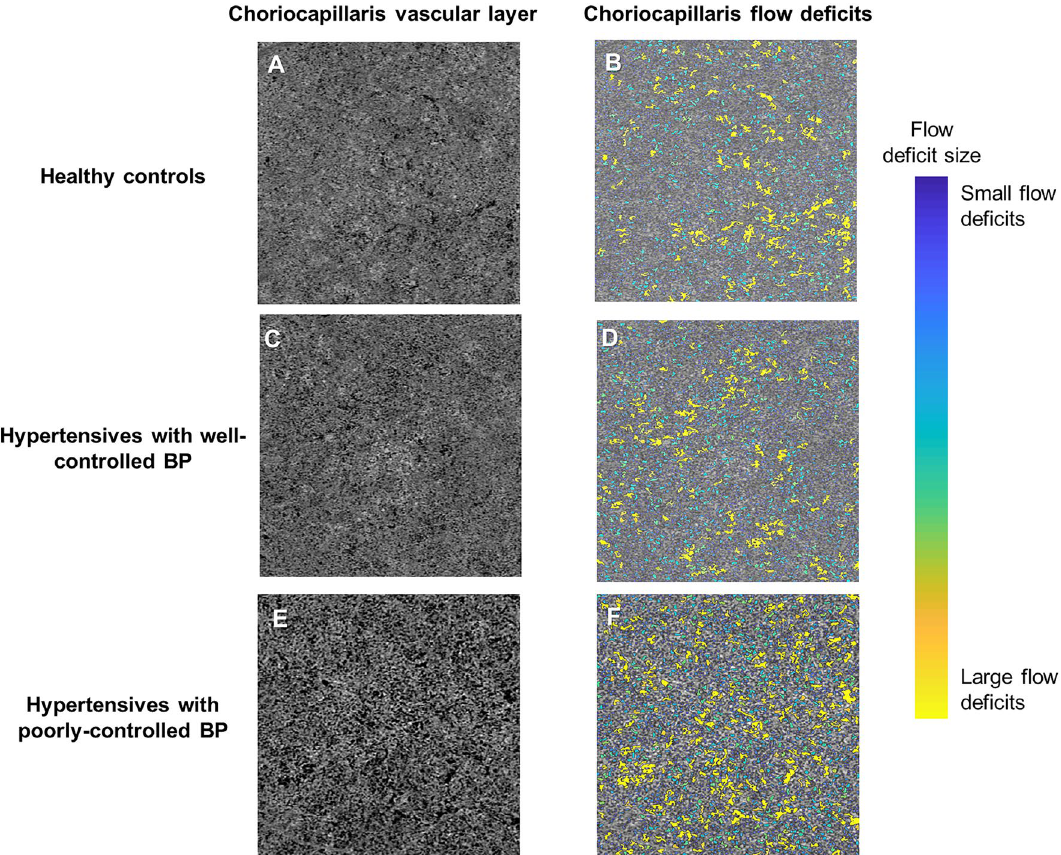
Figure 2. Swept source optical coherence tomography angiography (SS-OCTA; 3 × 3 mm2 area) and color ‐ coded maps indicating regions of choriocapillaris flow deficits (CFD) ( B , D and F ) of a choriocapillaris vascular layer of a healthy control individual (Top panel; A – B ), a hypertensive with well-controlled blood pressure (Middle panel; C – D ), and a hypertensive with poorly controlled blood pressure (Bottom panel; E – F ). Hypertensives with high BP tended to have larger sized CFD ( F ; labelled as yellow). The presence of flow deficits is areas of dark regions in the angiogram ( A , C and E ) and their sizes are color ‐ coded ( B , D and F ). Images ( A , C and E ) were generated from the built-in review software (PLEX Elite Review Software, Carl Zeiss Meditec, Inc., Dublin, USA; Version 1.7.1.31492; https ://www.zeiss .fr/conte nt/dam/Medit ec/inter natio nal/ifu/docum ents/plex-elite /curre nt/26600 21169 042_rev_a_artwo rk.pdf). The images ( B , D and F ) were generated from MATLAB software (The MathWorks, Inc.; Version R2018b; https ://www.mathw orks.com/produ cts/new_produ cts/relea se201